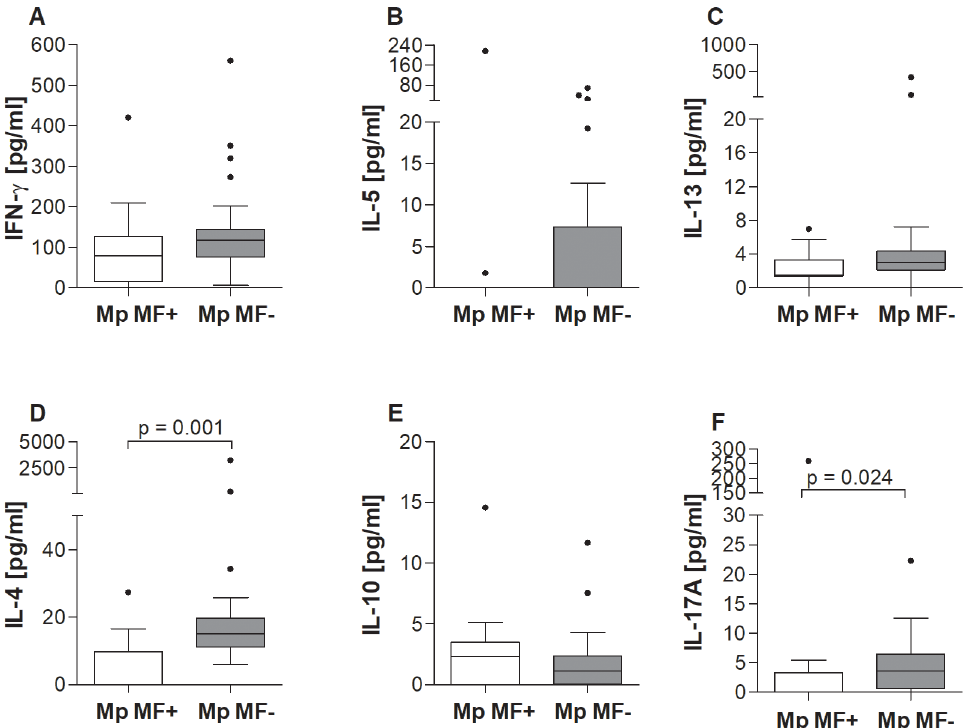
Fig 1. Reduced systemic IL-13, IL-4 and IL-17A levels in M . perstans microfilaremic individuals. Sera from M . perstans -microfilaremic (Mp MF+, n = 11) and amicrofilaremic (Mp MF-; n = 28) individuals were analyzed for the contents of ( A ) IFN- γ , ( B ) IL-5, ( C ) IL-13, ( D ) IL-4, ( E ) IL-10 and ( F ) IL-17A using luminex technology. Graphs show box whiskers with median, interquartile ranges and outliers. Statistical significances between the indicated groups were obtained using the Mann-Whitney-U-tests.